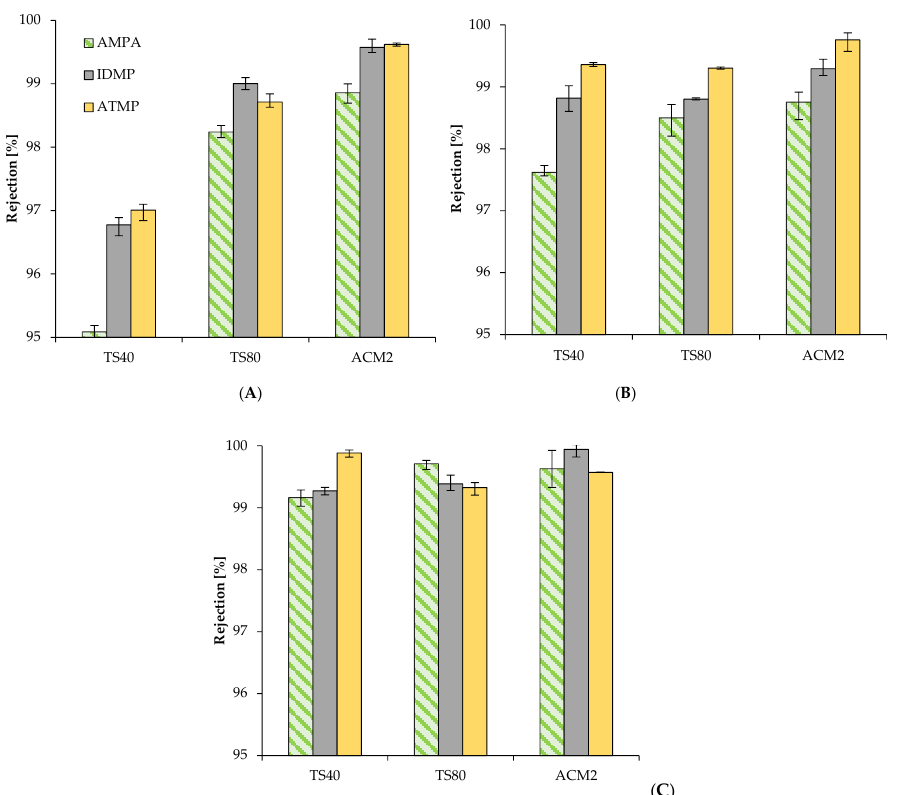
Figure 2. Rejection of ATMP, IDMP and AMPA with NF and RO membranes treated with three different water qualities based on TP analyses; ( A ) Ultra-pure water; ( B ) Synthetic tap water; ( C ) Local tap water; The feed concentration was 10 mg L − 1 for all phosphonates used.